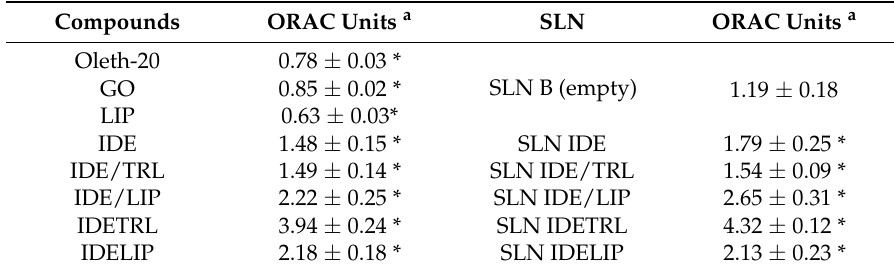
Table 2. Antioxidant activity expressed as ORAC units of IDE, IDE derivatives, SLN components, (Oleth-20, GO, LIP), unloaded and loaded